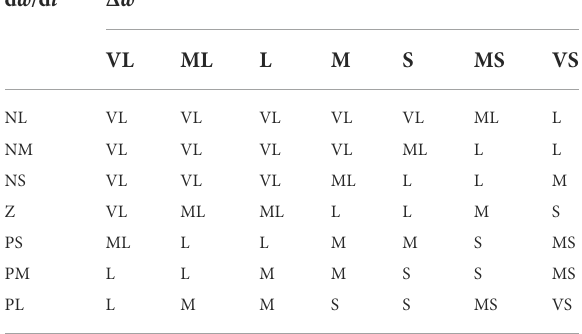
TABLE 1 Reasoning rules of